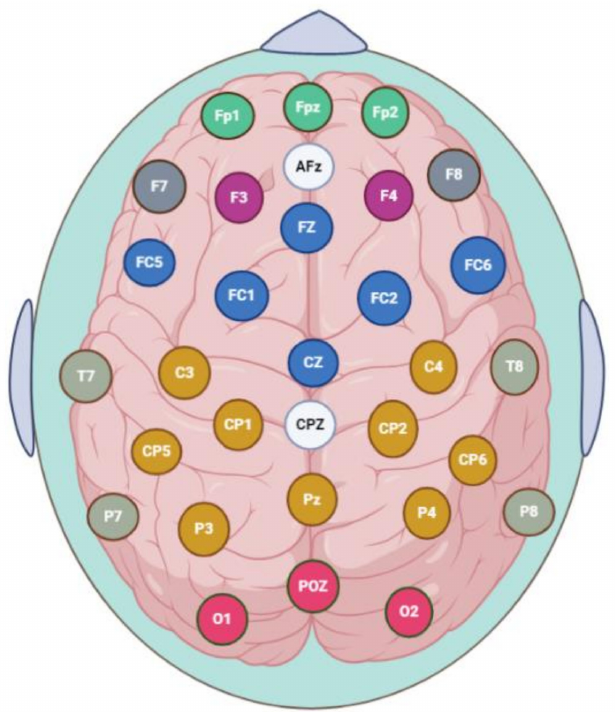
Figure 1. Topographical placement of 32 electrodes using the extended international system 10–20, indicating the distribution of the electrodes on the cortical scalp, categorized as follows: prefrontal (Fp1, Fp2), medial prefrontal—mPFC (Fpz), ventrolateral prefrontal (F7, F8), dorsolateral prefrontal (F3, F4), frontal (FC5, FC1, FC2, FC6), midfrontal (Fz, Cz), temporal (T7, T8, P7, P8), parietal (C3, C4, CP5, CP1, CP2, CP6, P3, P4), midparietal (Pz), occipital (O1, O2), and midoccipital (POz). The system is referenced to CPz, and grounded at